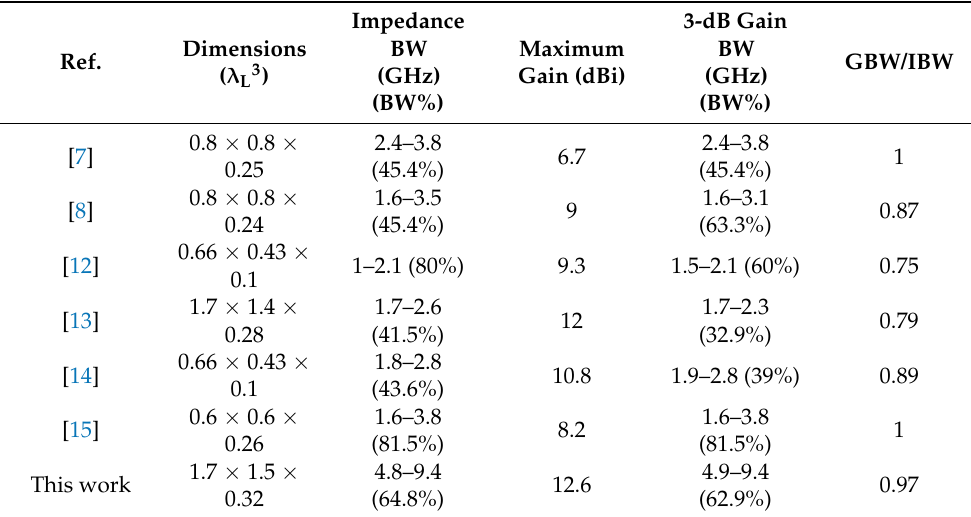
Table 2. Performance comparison between proposed and reported wideband high-gain antennas.